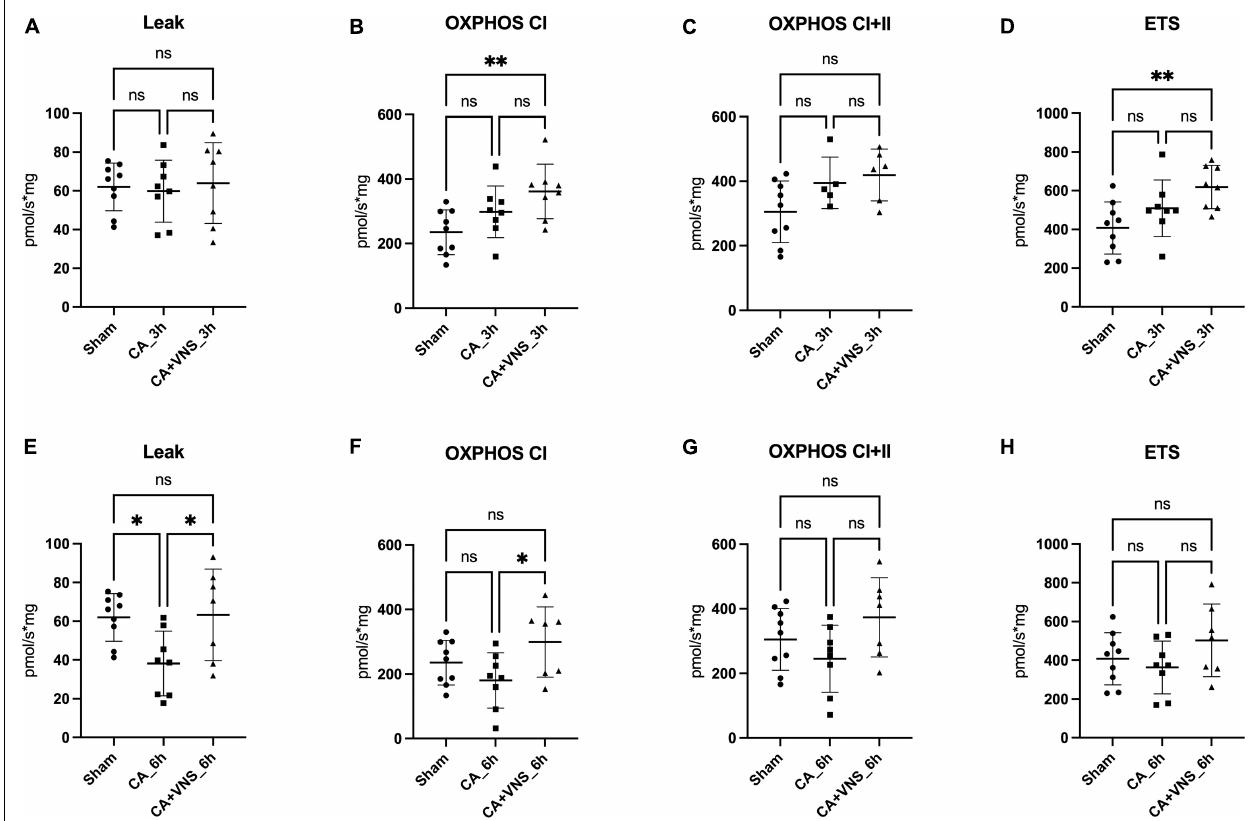
FIGURE 2 | Comparisons of mitochondrial respiration at 3 h and 6 h after ROSC. (A) Leak, (B) OXPHOS CI, (C) OXHPOS CI + II, and (D) ETS in the sham group ( n = 9), CA_3 h group ( n = 8), and CA + VNS_3 h group ( n = 8). (E) Leak, (F) OXPHOS CI, (G) OXHPOS CI + II, and (H) ETS in the sham group, CA_6 h group ( n = 8), and CA + VNS_6 h group ( n = 7). Data are presented as the mean ± standard deviation. One-way ANOVA with Bonferroni’s post hoc multiple comparisons test was performed (* P < 0.05; ** P < 0.01; ns, not significant); CA, cardiac arrest; ETS, electron transfer system; OXPHOS, oxidative phosphorylation capacity; VNS, vagal nerve stimulation.